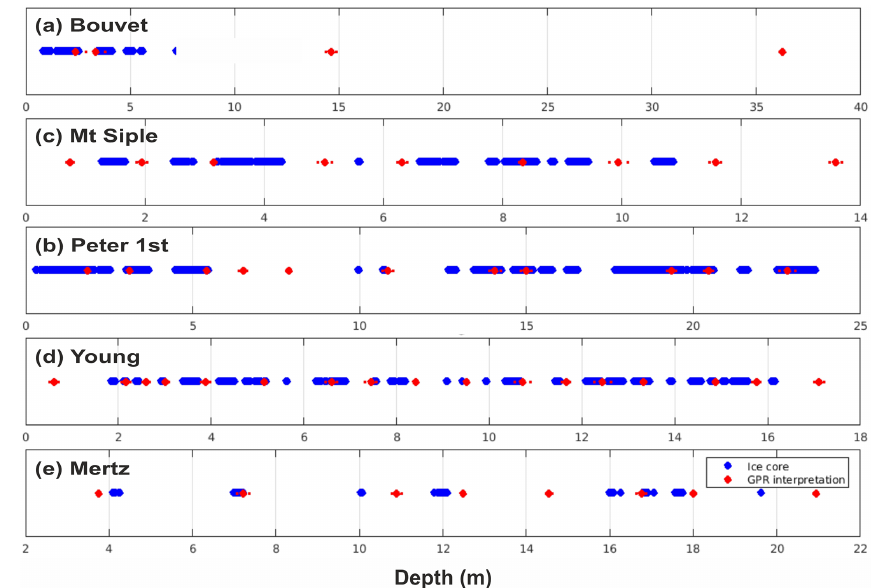
Figure 7. Comparison of detected layers (horizons) from GPR data (red dots; error bars: 1 standard deviation) and the potentially visible patterns of melt derived from the reduced-resolution ice core melt record (blue diamonds) for each